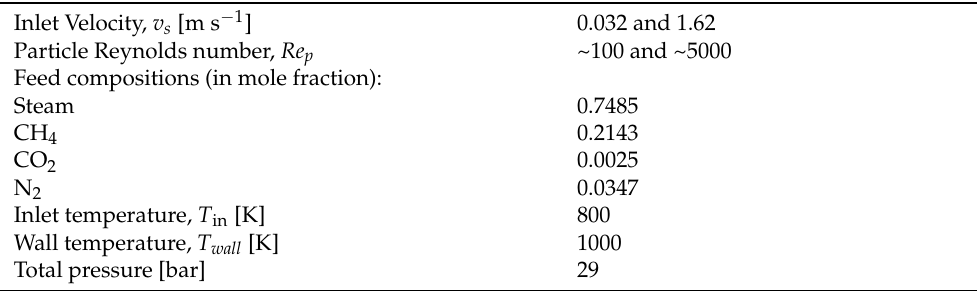
Table 2. CFD simulation inputs (pressure, temperature, feed gas from ref. [40,41]). Inlet Velocity, v s [m s − 1 ] 0.032 and 1.62 Particle Reynolds number, Re p ~100 and ~5000 Feed compositions (in mole